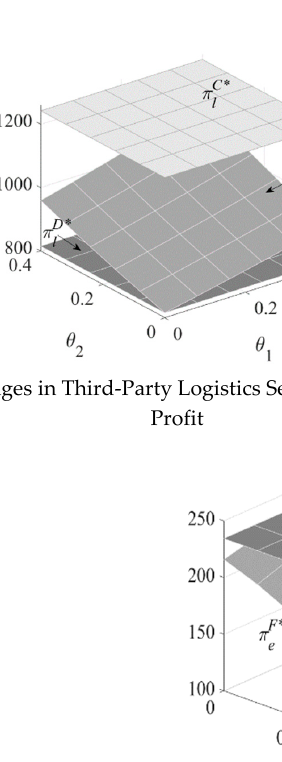
Figure 4. Changes in market demand and ESC profit with 𝜃 (cid:2869) and 𝜃 (cid:2870) .